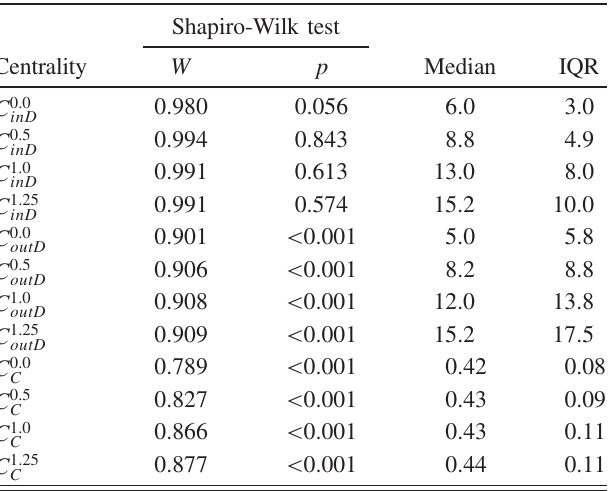
TABLE VI. The summary of the descriptive statistics for all centrality measures from fifth collection ( N ¼ 53 ). Based on the Shapiro-Wilk test, the null hypothesis about the normal distri- bution is rejected for outdegree and closeness, but not